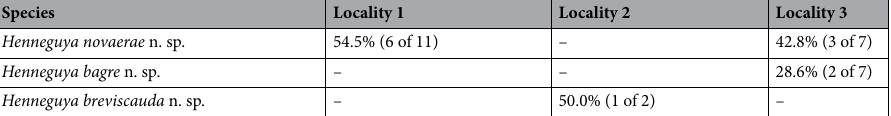
Table 1. Prevalence of each new Henneguya species found parasitizing the gills of Rhamdia quelen at different collection localities.